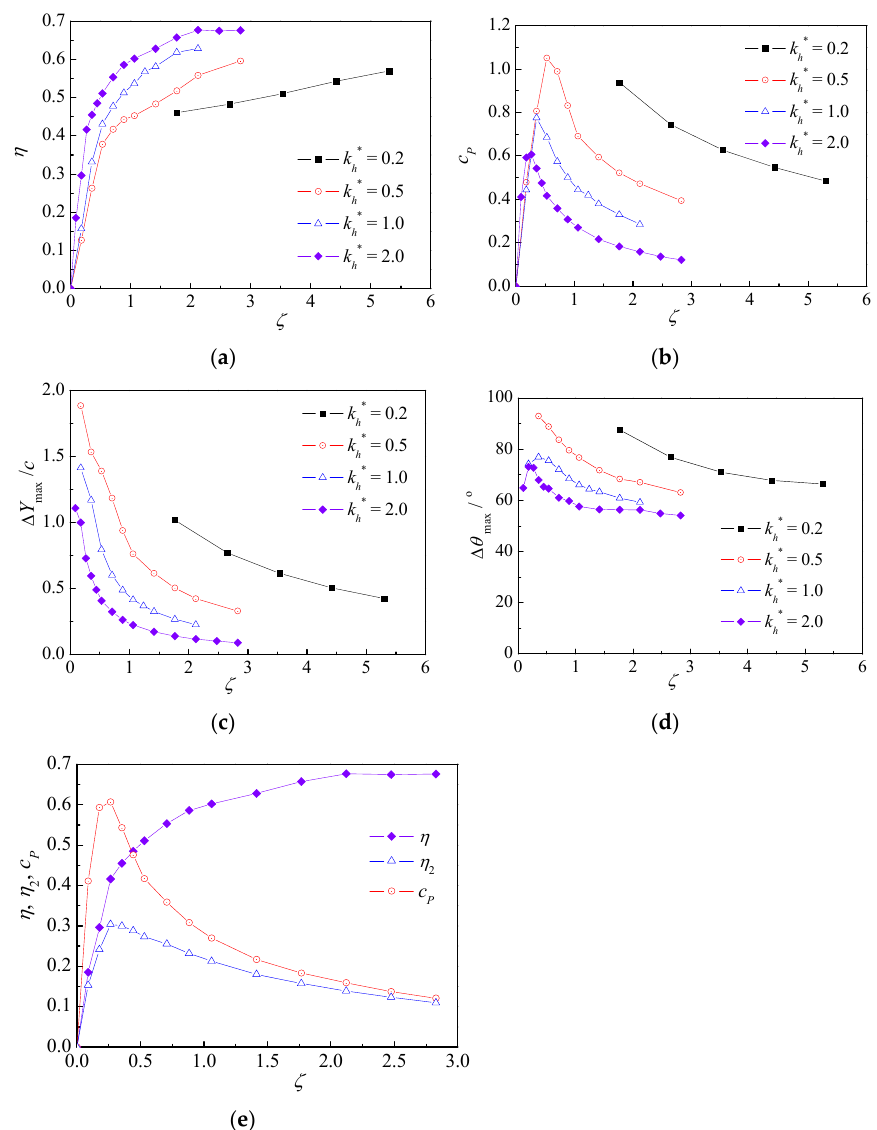
Figure 15. Foil performance as a function of the damping coefficient ζ for different heave spring stiffness coefficients ( k h *). ( a ) Efficiency η ; ( b ) power coefficient c p ; ( c ) heave amplitude Δ Y max / c ; ( d ) pitch amplitude Δθ max ; ( e ) with k h * = 2.0, hydraulic efficiency η 2 calculated by the larger value of the maximum heaving amplitude in the leading-edge point or trailing-edge point as sweep width.